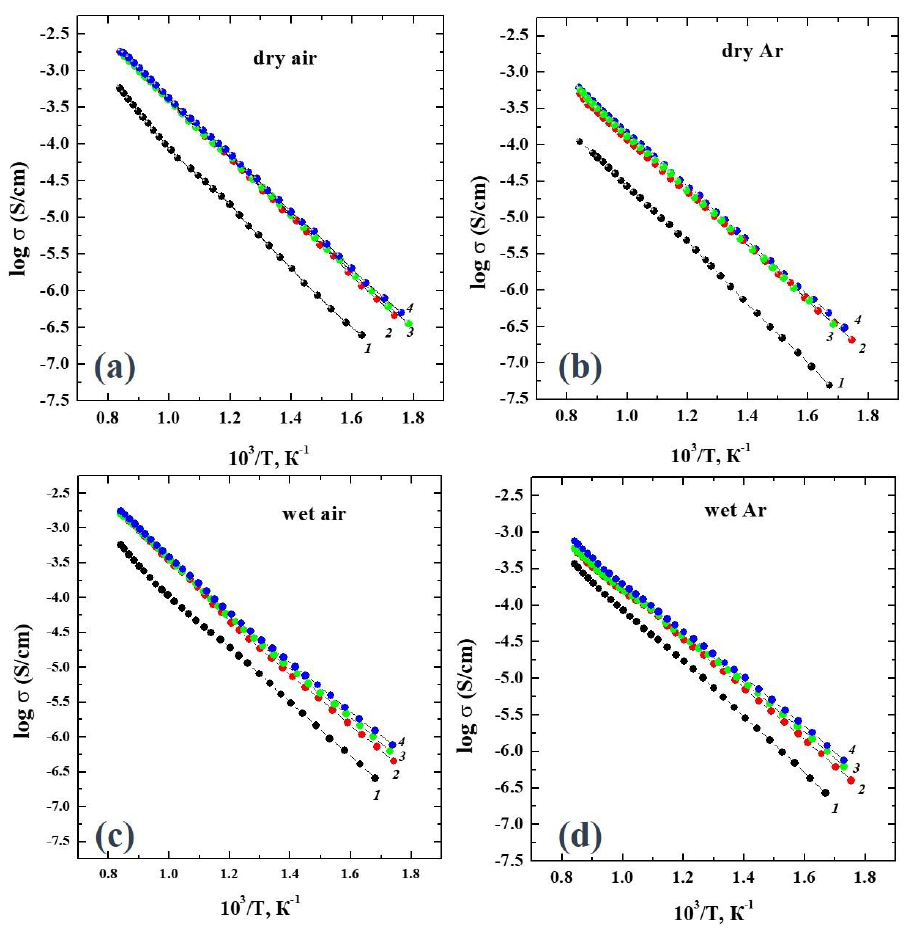
Figure 3. The temperature dependencies of conductivities for the compositions of BaLa 2–x Gd x In 2 O 7 at x = 0 (1), x = 0.05 (2), x = 0.10 (3) and x = 0.15 (4) obtained under ( a ) dry air, ( b ) dry Ar, ( c ) wet air and ( d ) wet